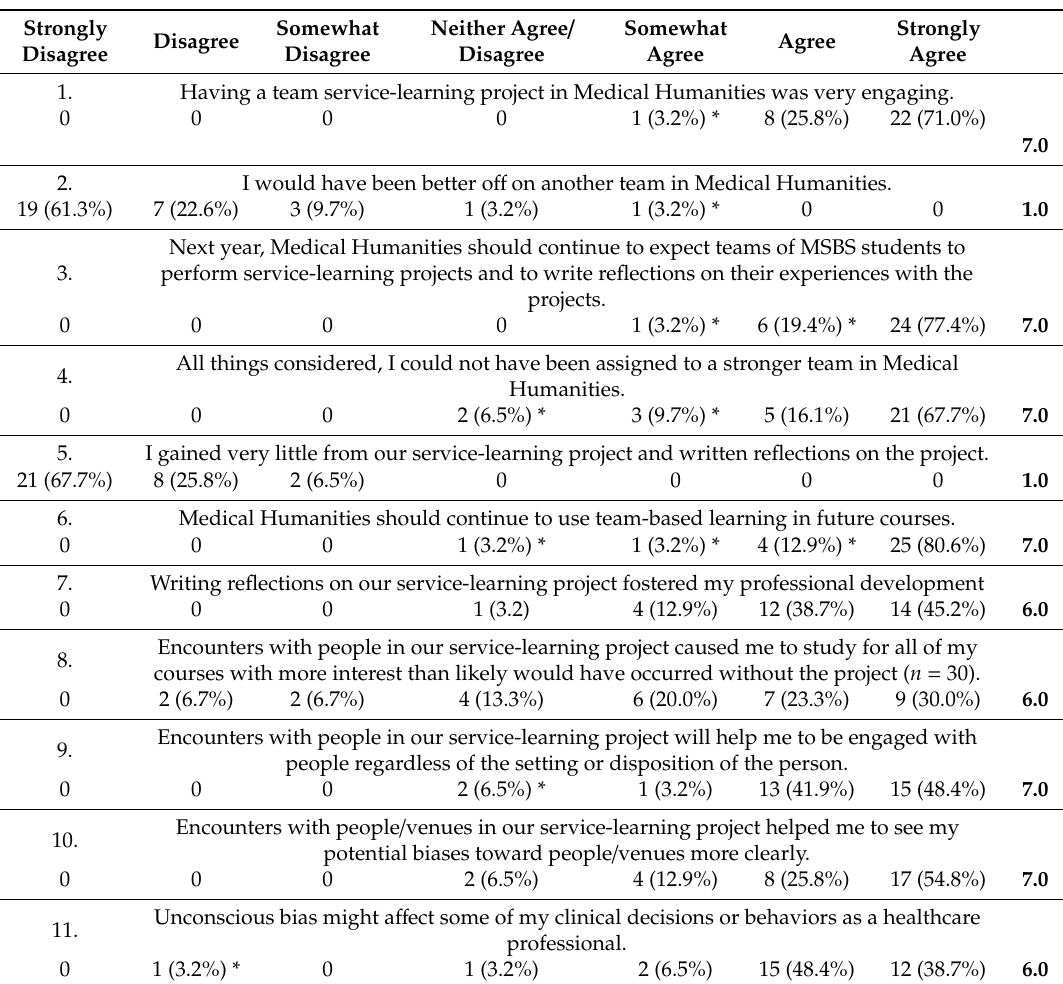
Table 1. Medians (bold italics) and distributions of responses to statements regarding team and service learning were each significantly di ff erent from neutral (i.e., 4.0) for all 11 items ( n = 31, p < 0.0001). * statistically significant